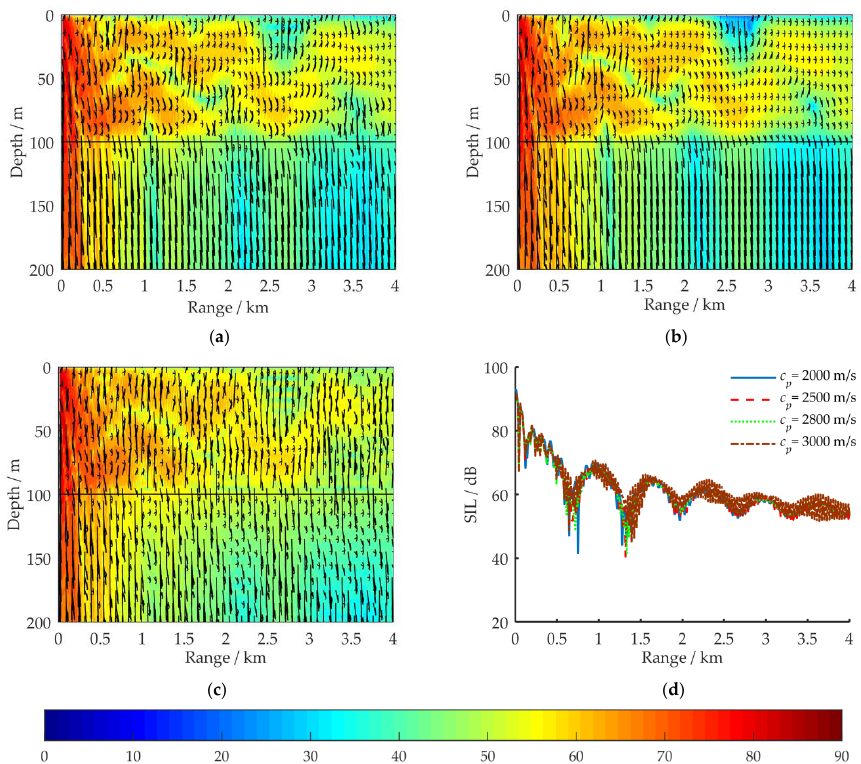
Figure 11. Distribution of the 100 Hz acoustic energy flux (SIL) in a full waveguide of shallow water for different S-wave speeds in sea bottom. ( a ) c s = 400 m/s; ( b ) c s = 600 m/s; ( c ) c s = 800 m/s; ( d ) comparison results of SIL curves for four types of simulation conditions: c p = 400, 600, 800, and 1000 m/s, with a receiving depth of z = 50 m.